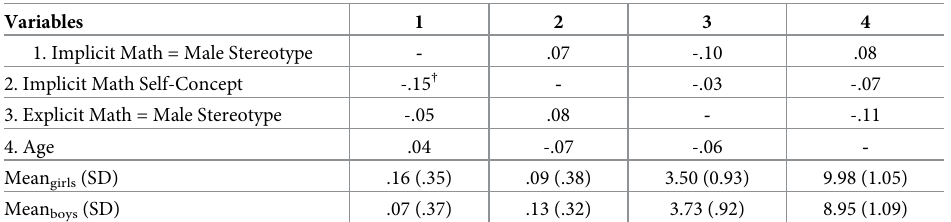
Table 1. Correlations and descriptive statistics for key variables (N girls = 151; N boys =